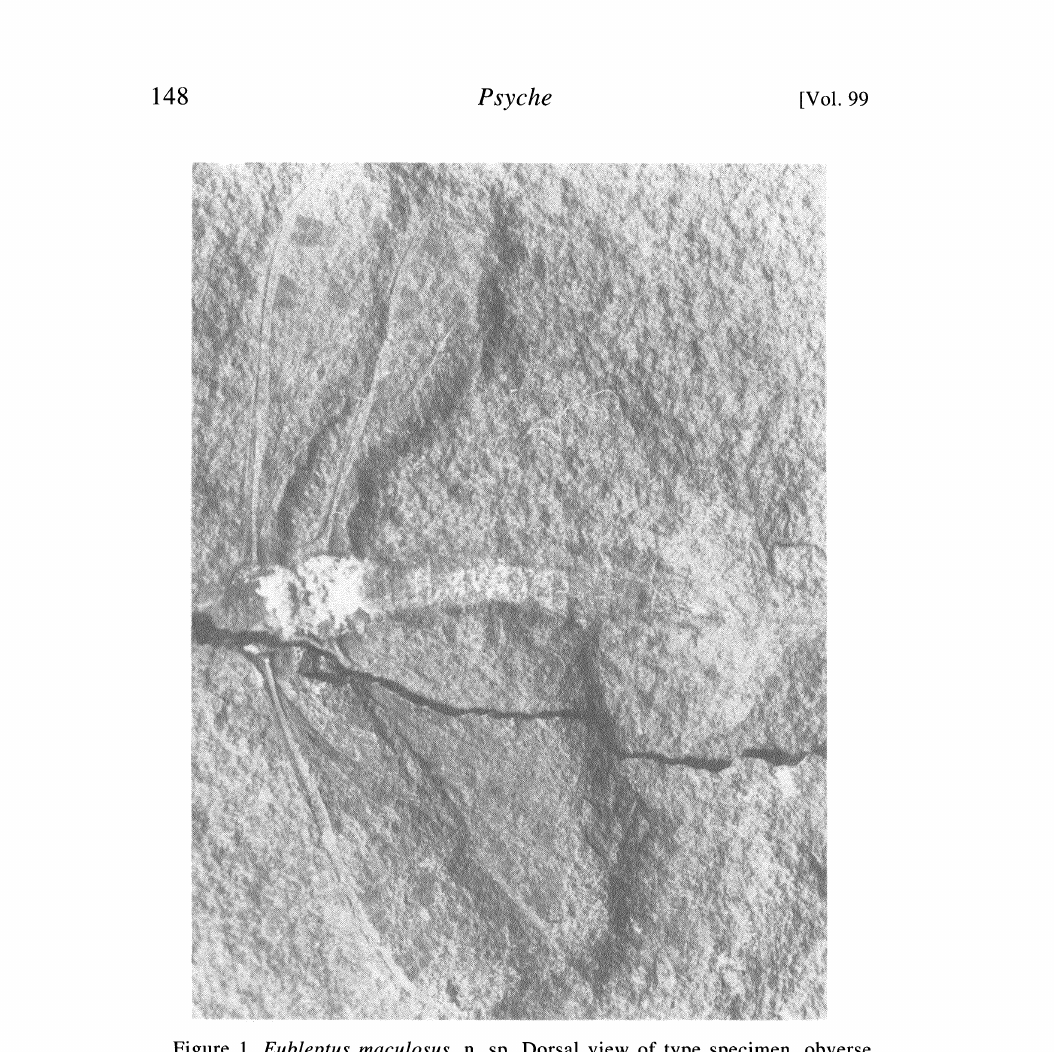
Figure 1. Eubleptus maculosus, n. sp. Dorsal view of type specimen, obverse half. Wing expanse, 32 mm. danielsi, are not clearly preserved in maculosus, and the head is not preserved at all. The fore and hind wings are 14 mm. long.